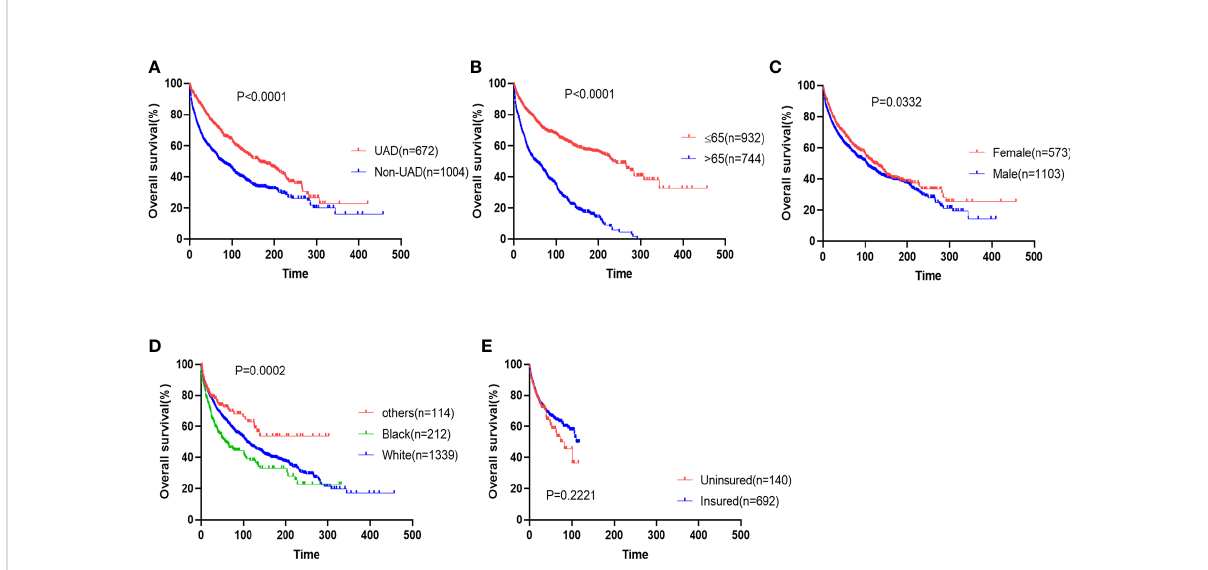
FIGURE 2 The impacts of sites (A) , age (B) , gender (C) , race (D) , and insurance status (E) on overall survival of patients with extramedullary